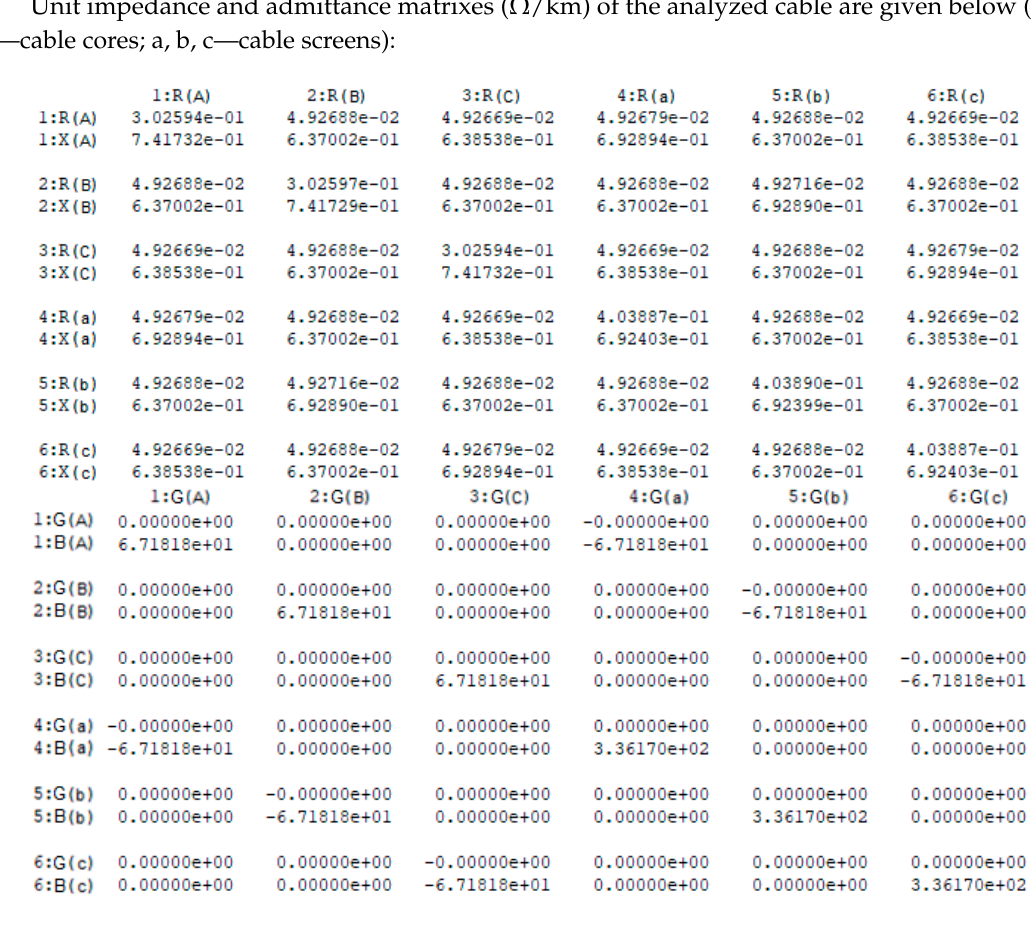
Figure 9. A schematic diagram of the simulations.